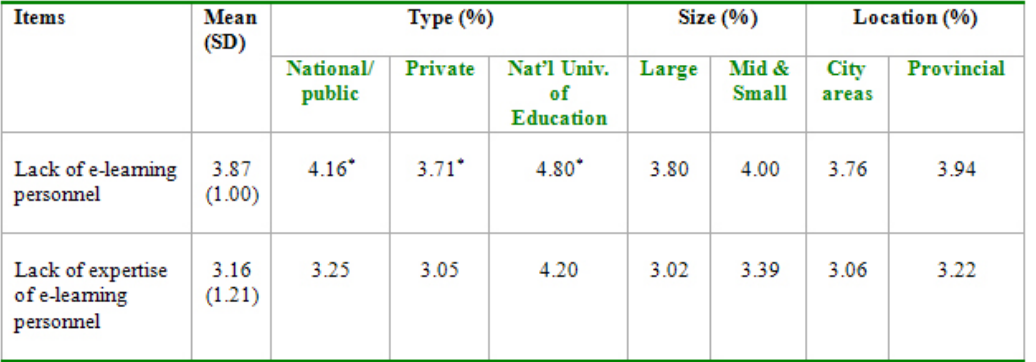
Table 5. Staffs’ Awareness on Problems in